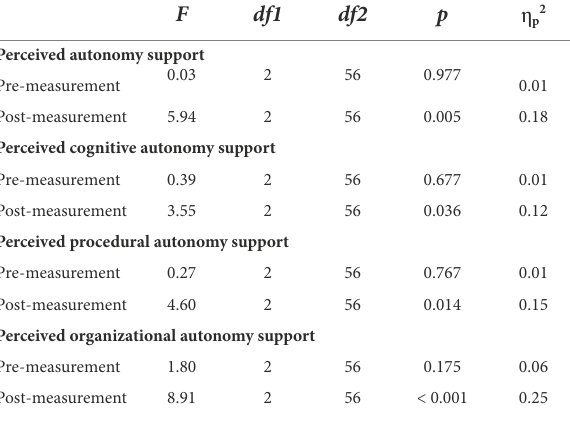
TABLE 1 Results of one-way ANOVA regarding perceived autonomy support (total score of the MD-PASS-PE) in the three different PE classes, pre- and